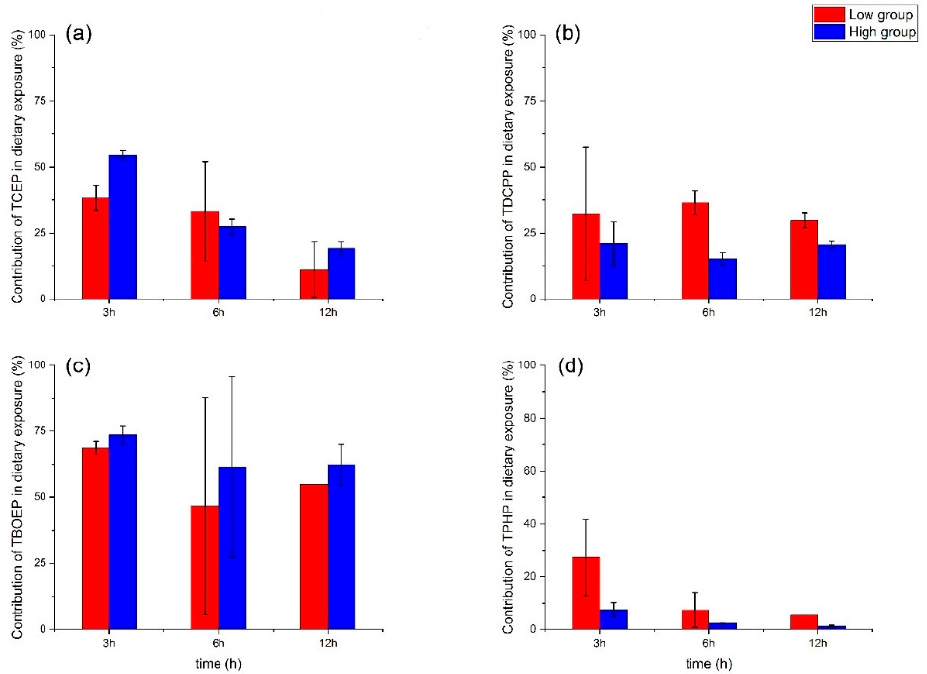
Figure 3. Contribution of OPEs (( a ) TCEP, ( b ) TDCPP, ( c ) TBOEP, ( d ) TPHP) in D. magna via dietary exposure relative to waterborne exposure. Red bars represent the low-concentration group (20 µ g/L), and blue bars represent the high-concentration group (100 µ g/L). The error bar represents the standard error.